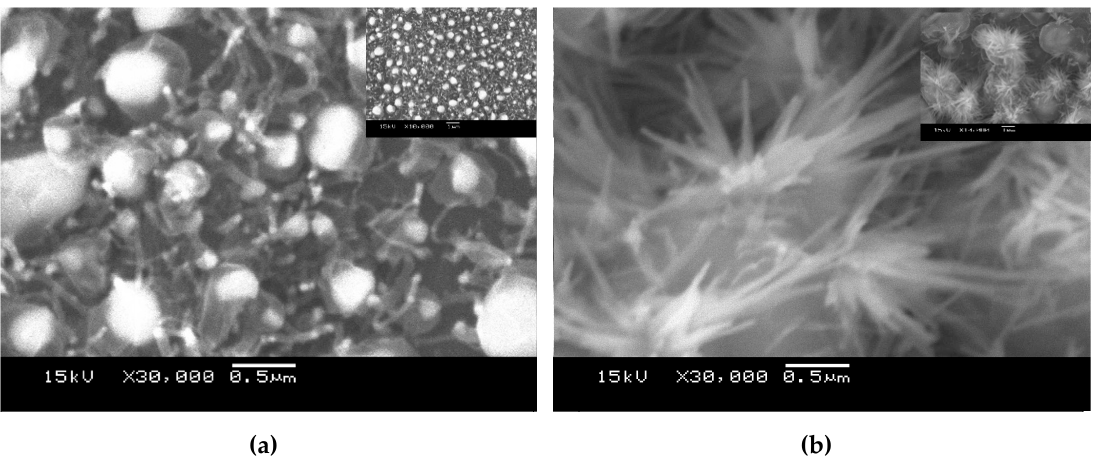
Figure 5. SEM images of carbon nanostructures on Cu-Cr film of different thicknesses by the CVD method in the presence of NH 3 gas. ( a ) 100 nm; ( b ) 500 nm.